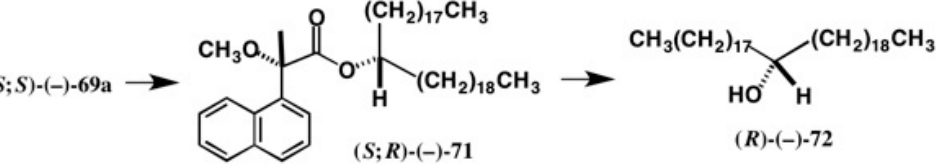
Figure 53. Preparation of enantiopure long chain alcohol with ultimate cryptochirality ( R )-( − )- 72 .